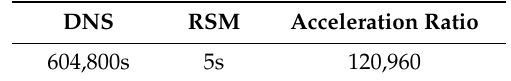
Table 3. Computational time.